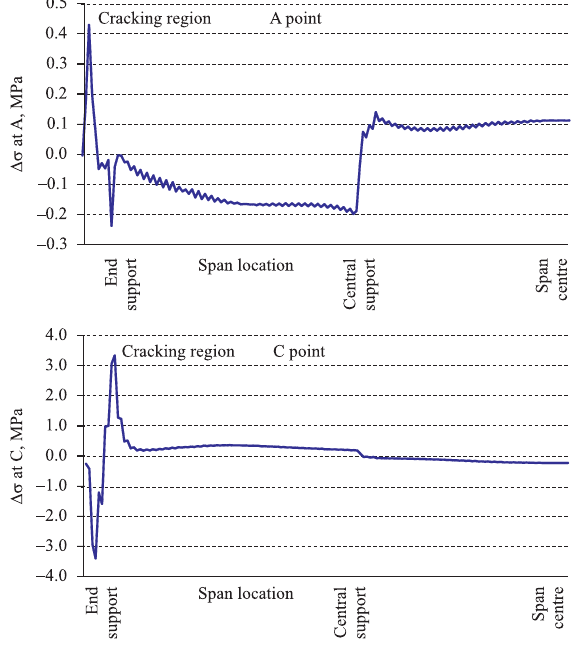
Fig. 12. The crack location of box girder: a – the location of bottom slab cracking; b – the location of web cracking